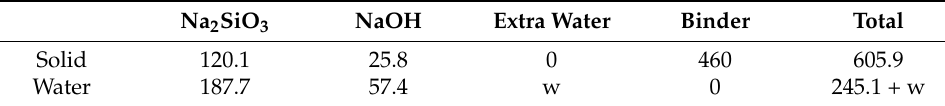
Table 3. Data tabulation: calculating added water